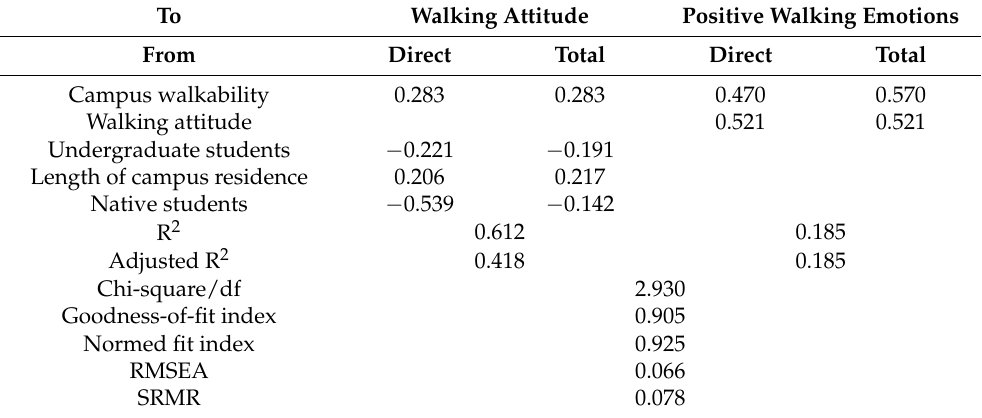
Table 3. SEM Results—Standardized Coefficients. To Walking Attitude Positive Walking Emotions From Direct Total Direct Total Campus walkability 0.283 0.283 0.570 Walking attitude 0.521